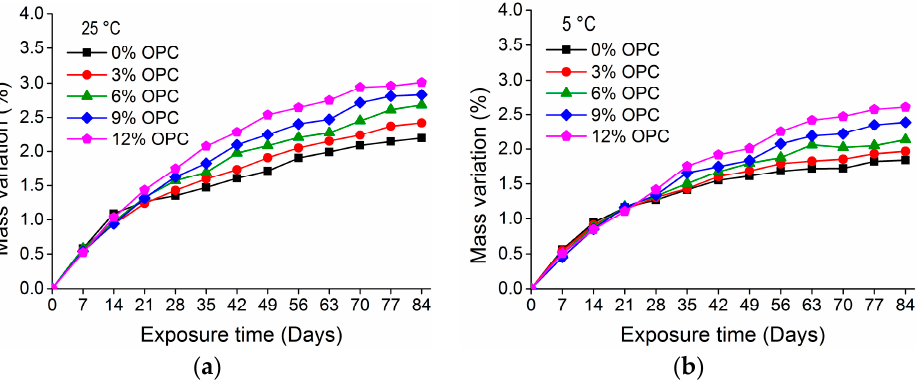
Figure 7. Mass variation in nano-TiO 2 containing OPC mortars immersed in 10% Na 2 SO 4 solution at